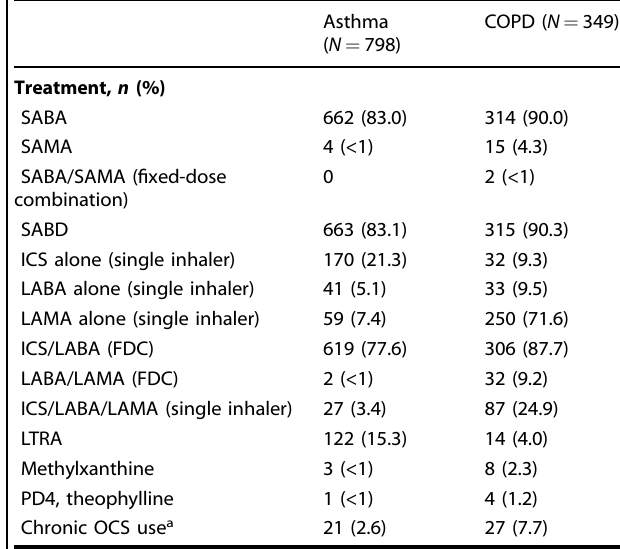
Table 5. Most recent BMI result and self-reported smoking status recorded in primary care EHR in the 24 months prior to Ext-SLS consent.